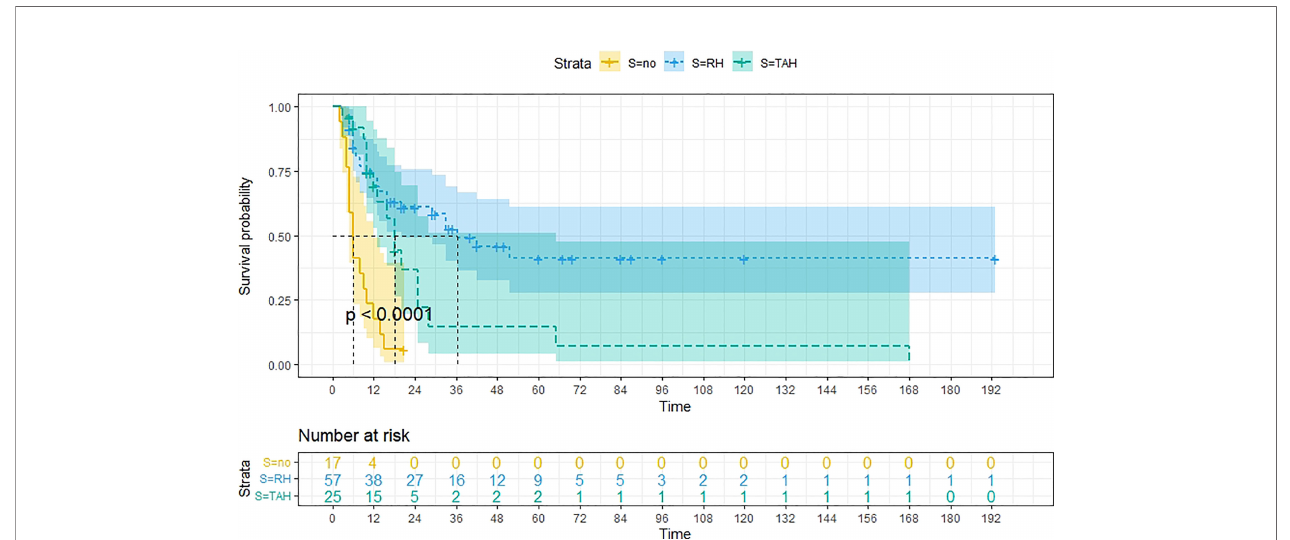
FIGURE 4 | Kaplan-Meier survival curves for OS in patients of no surgery, TAH-based surgery, RH-based surgery. The median OS for them are 6m, 18m, 36m, respectively.